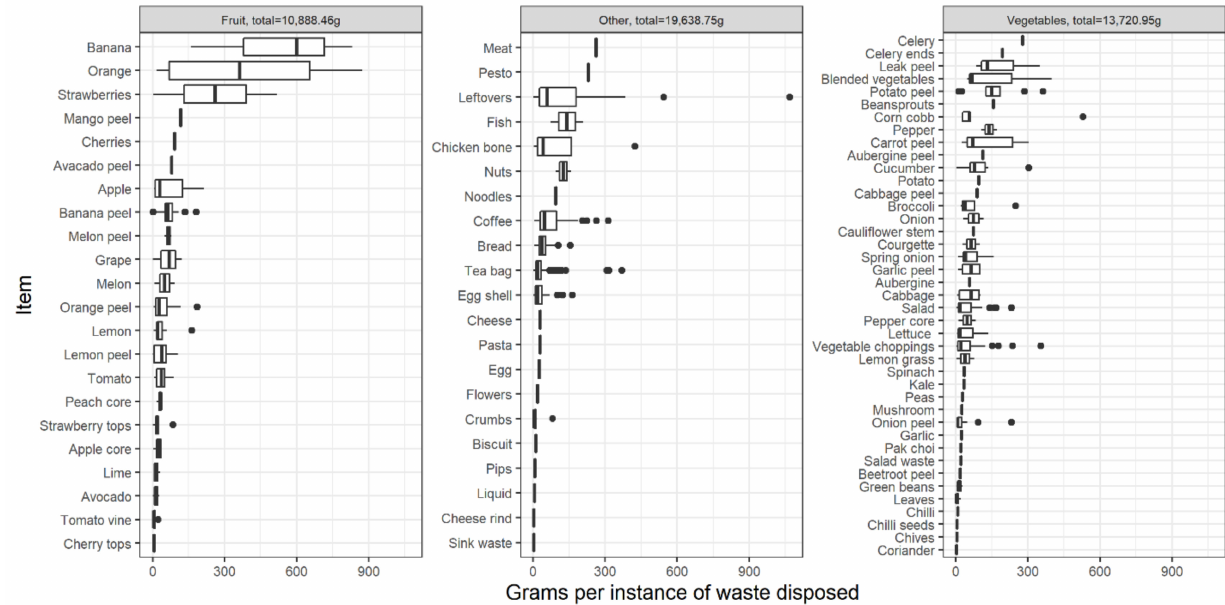
Figure 8. Rate of change in weight by item.